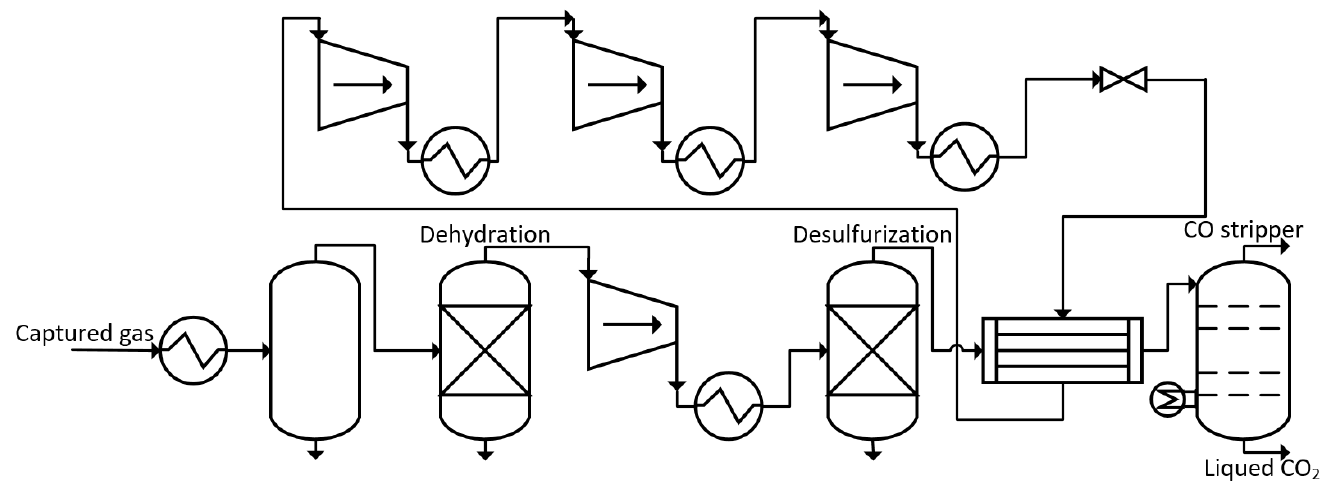
Figure 11. Process flow diagram for the closed-cycle configuration 1.